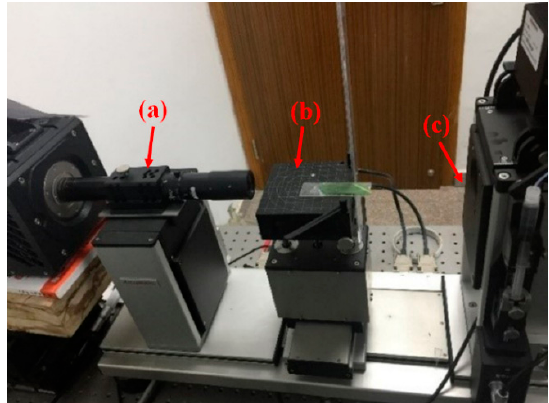
Figure 1. Contact angle measuring device: high speed camera ( a ), sample platform ( b ) and contact angle measuring device ( c ).